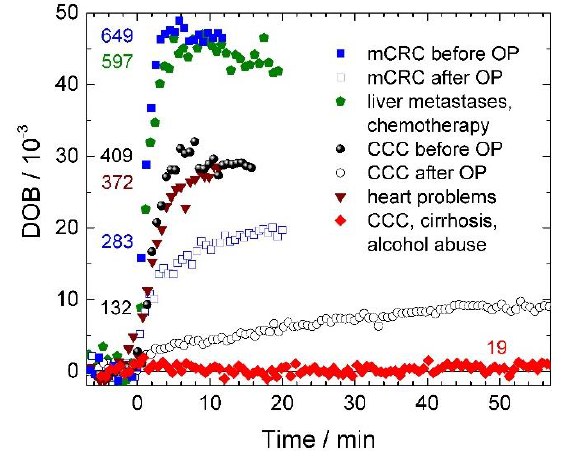
Figure 5. DOB kinetics of five different patients (blue, green, black, wine, and red) with different liver statuses as a function of time. Administration of 13 C-methacetin is at time zero. A patient with mCRC (metastatic colorectal cancer) before and after operation (filled and open blue squares), patient with liver metastases and after chemotherapy (green pentagon), patient with CCC (cholangiocellular carcinoma), before and after operation (filled and open black circles), patient with heart problems (wine triangles), and a patient with CCC, cirrhosis, and alcohol abuse (red diamond). LiMAx values in µg/kg/h for presented DOB kinetics are given as numbers next to the kinetics.